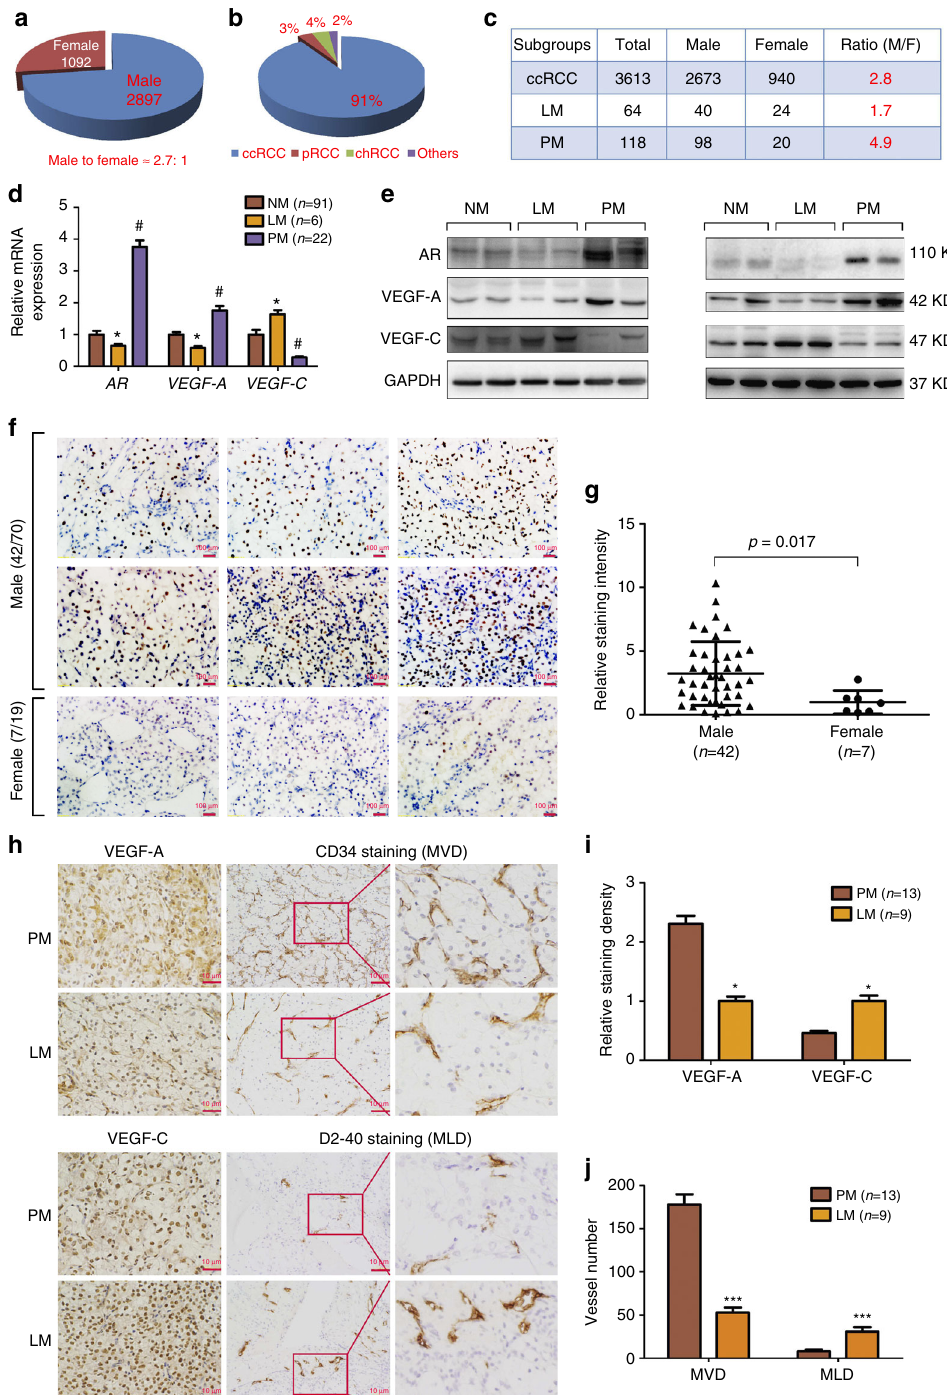
Fig. 1 Differential AR expression in pulmonary vs. lymphatic metastasis of ccRCC. a – c Gender difference of RCC incidence in 3989 cases from the Chinese PLA Hospital. The left pie chart ( a ) indicates the constituent ratio of male and female and the right pie chart ( b ) indicates the constituent ratio of tumor subtypes in this RCC cohort. The table ( c ) indicates the gender difference in different groups including ccRCC population, pulmonary metastatic (PM) ccRCC, and lymphatic metastatic (LM) ccRCC. d mRNA expressions of AR, VEGF-A, and VEGF-C in non-metastatic ccRCC (NM, n = 91), LM ccRCC ( n = 6), and PM ccRCC ( n = 22) in 119 cases of ccRCC specimens. The AR expression was normalized against TATA box binding protein (TBP) expression.* p < 0.05, LM was compared to NM, and # p < 0.05, PM was compared to NM. e Protein levels of AR, VEGF-A, and VEGF-C were detected by western blot in NM, LM, and PM specimens. f Representative AR staining in various ccRCC tumors showed that AR expression was mainly located in the nucleus. Scale bar , 100 μ m. g The AR expression intensity of AR-positive RCC in males ( n = 42) was also higher than that in females ( n = 7) by analyzing the signaling of IHC staining using Image-Pro Plus software. h Representative IHC staining of angiogenic and lymphangiogenic microvessel density (MVD ( upper ), and MLD ( lower ), respectively), VEGF-A and VEGF-C in PM ( n = 13) and LM ( n = 9). Scale bar , 10 μ m. i Quantitation of VEGF-A ( upper ) and VEGF-C ( lower ) expressions detected by immunohistochemistry using Image-Pro Plus software. j An average of fi ve random views of MVD and MLD were calculated in every slide and mean and standard error were shown for every group. * p < 0.05, *** p < 0.001 by t -test for two groups or ANOVA for more than two groups NATURE COMMUNICATIONS | 8: